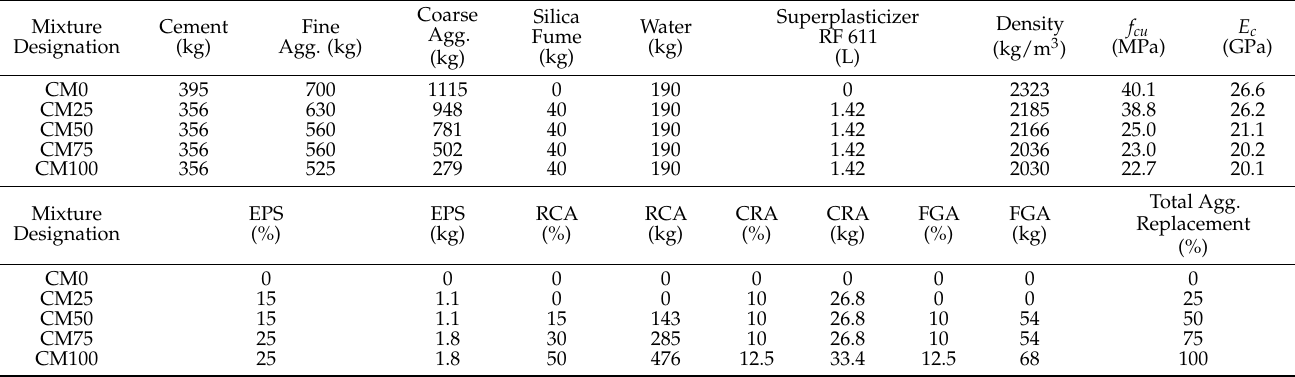
Figure 3. Recycled aggregate materials used in the concrete mixture. Table 2. Proportion of the concrete mixtures (kg/m 3 ).